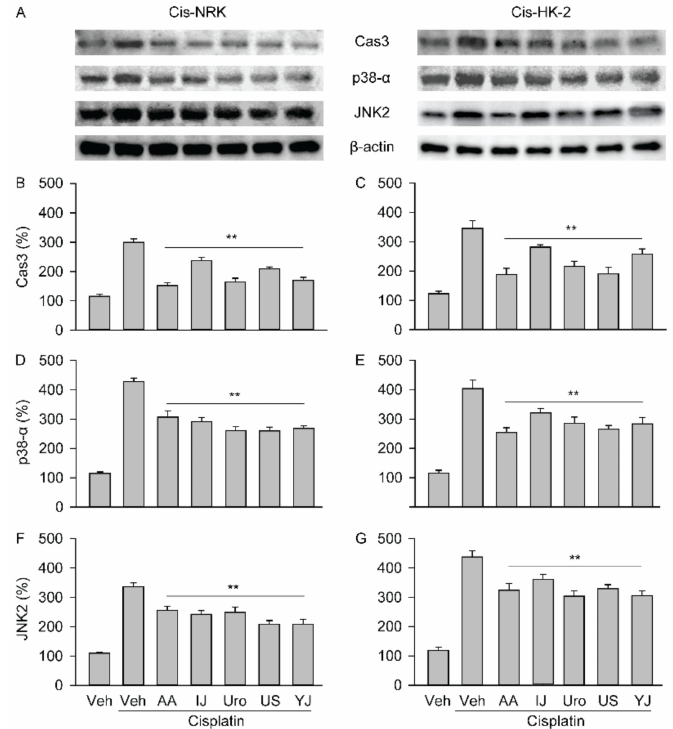
Figure 6. E ff ects on the expression of cleaved caspase-3 and activated mitogen-activated protein kinase (MAPK)-related proteins. The cisplatin-induced cells were treated with AA, IJ, Uro, US, or YJ for 3 days, and the expression of cleaved caspase 3 (Cas3) and phosphorylated MAPK proteins, p-38 α and c-Jun N-terminal kinase (JNK2), was assessed using western-blotting ( A ). The expression was normalized to the levels of β -actin. The results are expressed as percentages of the cisplatin non-treated control ( B – G ). Values are means ± SD from three independent experiments. **: p < 0.01 versus the cisplatin-treated Veh